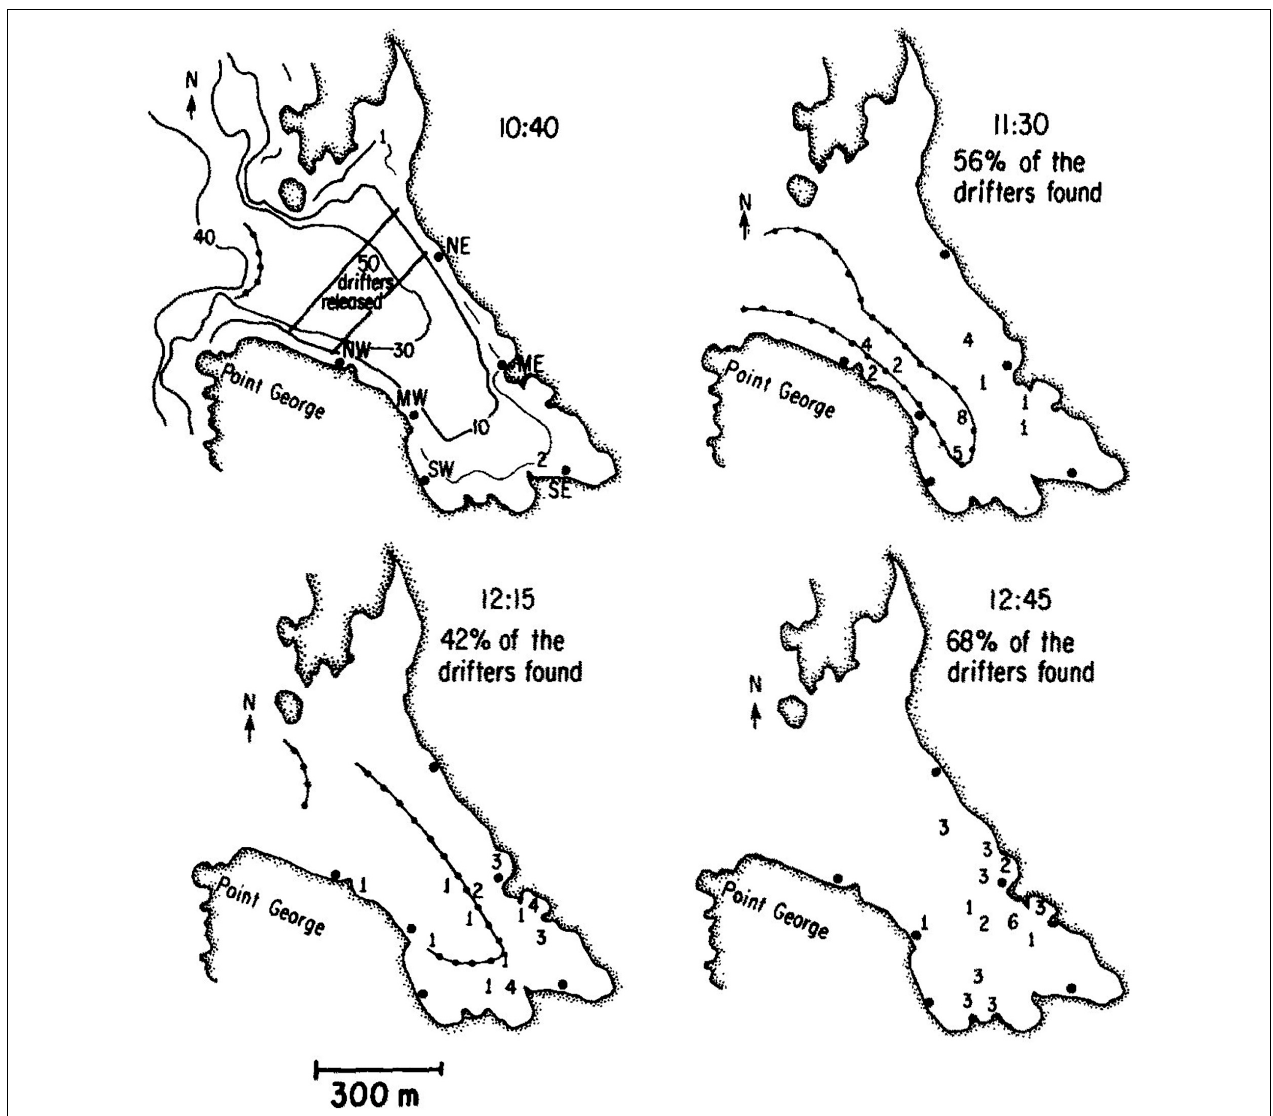
FIGURE 7 | The initial experiment at Park Bay, San Juan Archipelago Washington state to test if transport by internal wave convergences would differentially transport and deposit surface drifters in the intertidal zone (Shanks and Wright, 1987). In the 10:40 image, depth contours are in meters. The letters around the shore indicate the locations where we sampled barnacle cyprids settlement in the intertidal zone. Zooplankton sampling indicated that barnacle cyprids were captured, concentrated and transported by internal wave convergences. At 10:40 an internal wave convergence had formed at the mouth of Park Bay (line with dots). 50 plastic surface drifters were set across the Bay in two lines. These were then followed for roughly 2 h as the internal wave convergence propagated into the Bay. The small numbers indicate the number drifters observed at each observation time. Drifters tended to be transported to the areas of the shore around intertidal sample site ME and between SW and SE. Figure modified from that in Shanks and Wright (Shanks and Wright,